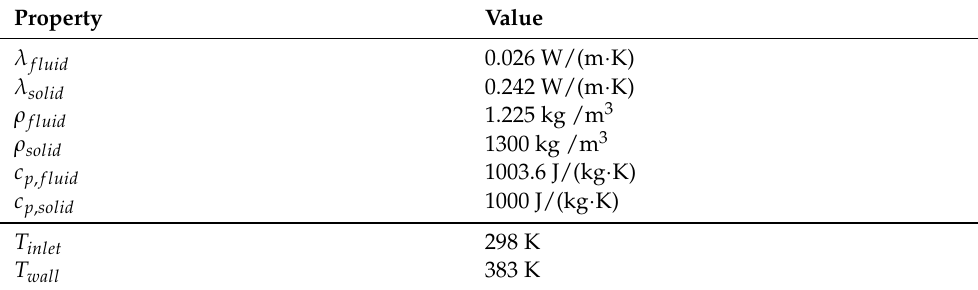
Table 4. Settings for the heat transfer validation simulation in Section